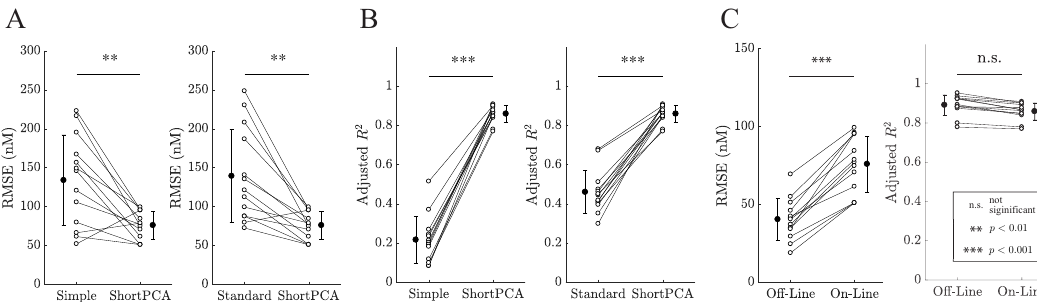
Figure 3. Comparisons of performance indicators: root-mean-squared error (RMSE) and adjusted R 2 . ( A ) RMSE and ( B ) adjusted R 2 of rt-ShortPCA GLM were compared with on-line methods and with ( C ) off-line. Open circles show means of each subject across all channels. Filled circles and error bars represent the mean and standard deviation across subjects,